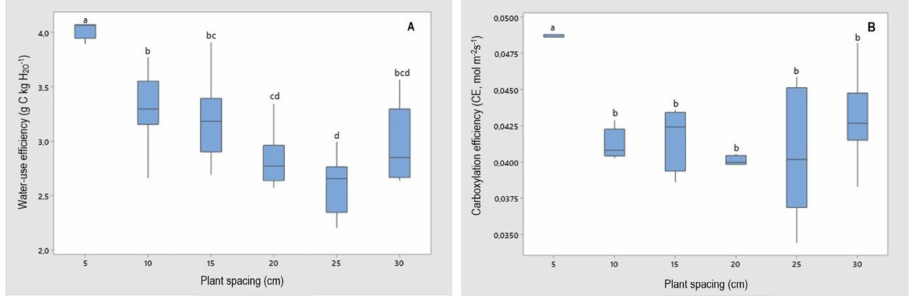
Figure 10. The response to water-use efficiency (WUE) ( A ), carboxylation efficiency ( B ) of strawberry plants cv. ‘Pircinque’, in different spacing between plants with average of the 2018/2019 and 2019/2020 harvests. For each spacing, the different letters indicate significant differences ( p ≤ 0.05).